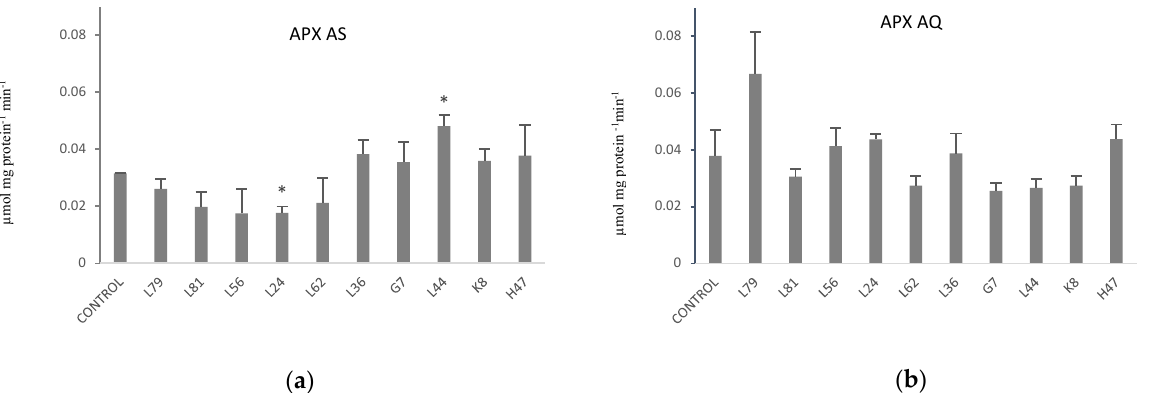
Figure 5. Ascorbate peroxidase activity (µmol mg protein − 1 min − 1 ) in ( a ) AS and ( b ) AQ leaves in plants inoculated with the 10 PGPB and non-inoculated controls. Values are the average ± SE (n = 3). Asterisks (*) indicate significant differences with the controls according to t student ( p < 0.05). Antioxidants concentration was affected by inoculation of PGPBs in both varieties (Figures 6–8), both in total amounts and in the oxidized/reduced ratio for AsA and gluta- thione. For the ascorbate pool (AsA/dAsA) is 30% lower in AQ tan in AS (Table 1). The trend in AS was to significantly reduce the total amount of ascorbate, reflected in both species except for L62, that caused a significant increase in both (Figure 6a). In AQ (Figure 6b), all strains except L62, induced a significant decrease in AsA, except K8 and L44 that also decreased dAsA.